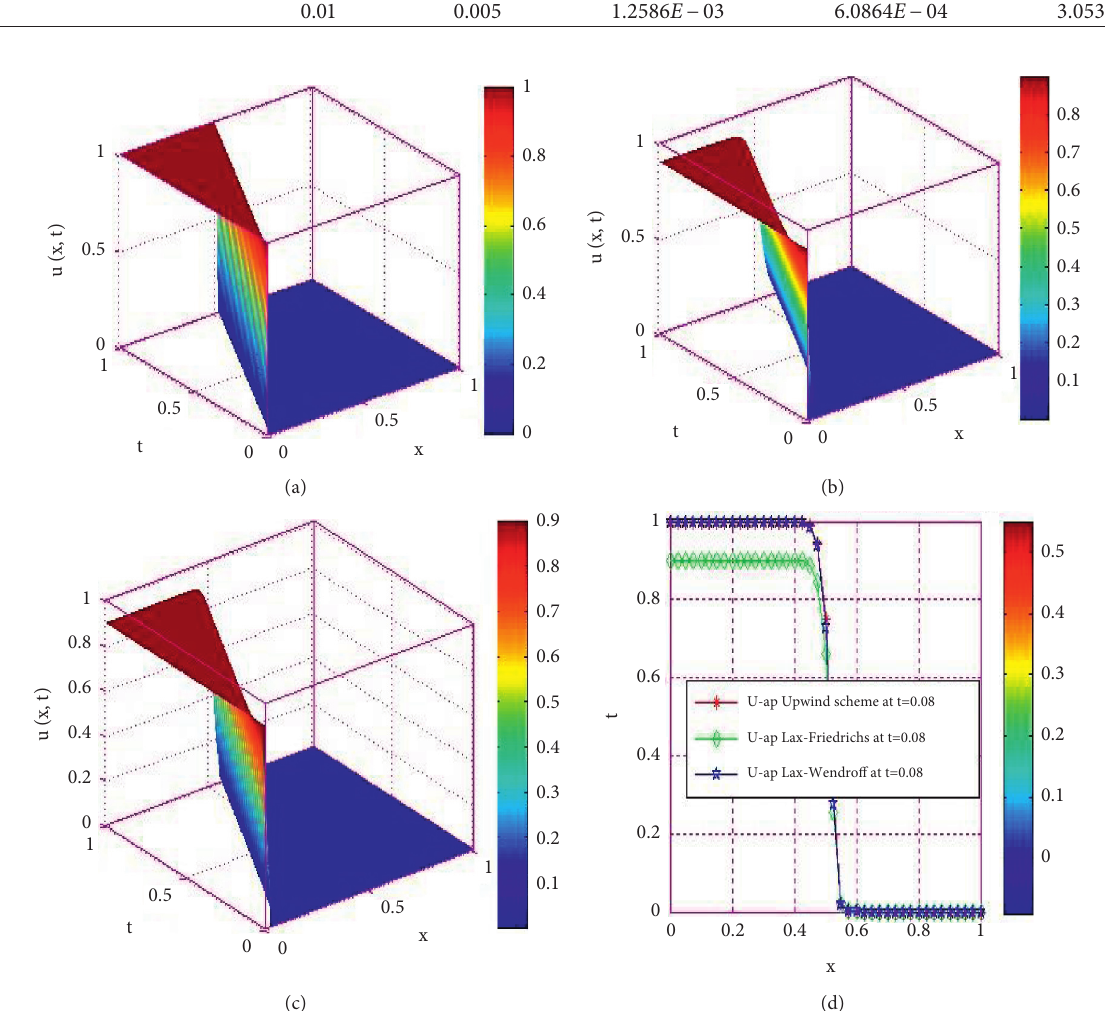
Figure 1: Solution profile of Example one subjected to discontinuous (shock) initial condition on the uniform mesh of maximum number grid point is Mx � 100 & time step is Δ t � 0 . 001. (a) Solution obtained by the upwind scheme; (b) solution obtained by Lax–Friedrichs scheme; (c) solution obtained by Lax–Wendroff scheme; (d) comparison of numerical solution at selected time